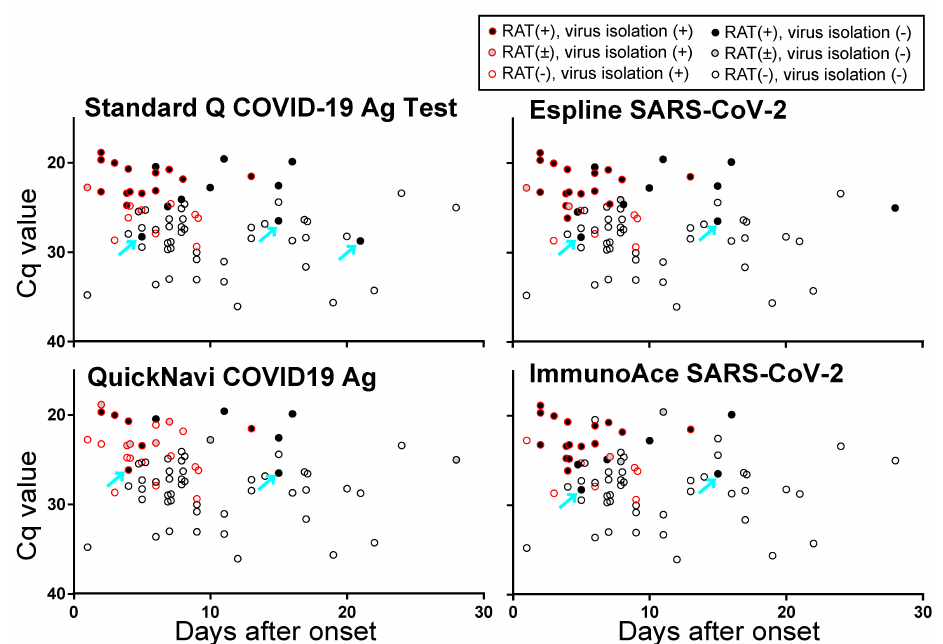
Figure 1. Results of RATs plotted based on the Cq value of RT-qPCR and days after onset. Viral antigens in 76 clinical specimens (7 gargle lavages, 27 saliva, 2 T swabs, 1 nasal vestibule swabs, 18 N swabs, 4 sputum, and 17 tracheal aspirates) were examined by Standard Q COVID-19 Ag, Espline SARS-CoV-2, QuickNavi COVID19 Ag, and ImmunoAce SARS-CoV-2. Two independent experiments were performed. All specimens were also tested by RT-qPCR and subjected to virus isolation. Open red circles indicate specimens from which virus was isolated; open black circles indicate specimens from which virus was not isolated. Circles filled in black indicate both results were positive, those filled in gray indicate that one was positive, no color indicates both were negative. Since the type of specimen likely affects the sensitivity of RATs, we assessed our results according to specimen type (gargle lavage, saliva, T swab, nasal vestibule swab, N swab, sputum, and tracheal aspirate). Although the Cq value varied between specimens from 18.8 to 36.0, gargle lavage, T swabs, and nasal vestibule swabs showed higher Cq values than the other types of specimens (Table 3). All four RATs detected virus antigens in one sputum sample, although no virus was isolated from 4 sputum samples tested. All four RATs failed to detect virus antigens in all 7 gargle lavages, 2 T swabs, and 1 nasal vestibule swabs, although the virus was isolated from one T swab sample. Since N swabs and saliva are suitable specimens for diagnosis in clinics, we plotted the results from the RATs and virus isolation based on the number of days after onset that the specimens were collected and the Cq values of the RT-qPCR (Figure 2). Standard Q COVID-19 Ag, Espline SARS- CoV-2, and ImmunoAce SARS-CoV-2 efficiently detected virus antigens in N swabs and saliva with low Cq values (Cq < 25) that were collected at early timepoints after onset.